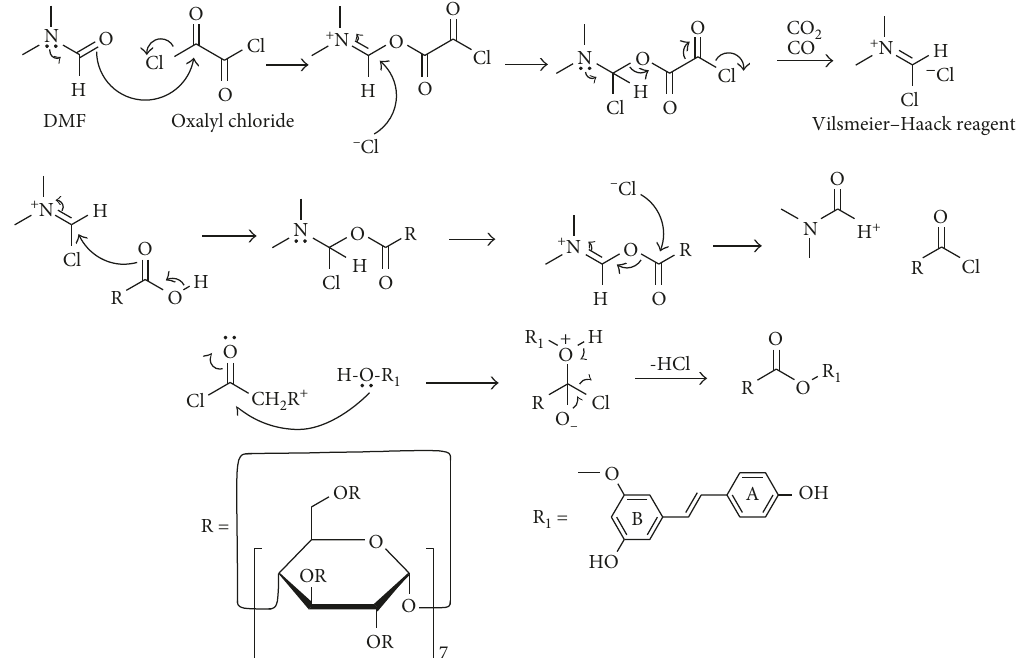
Figure 3: The reaction mechanism of the